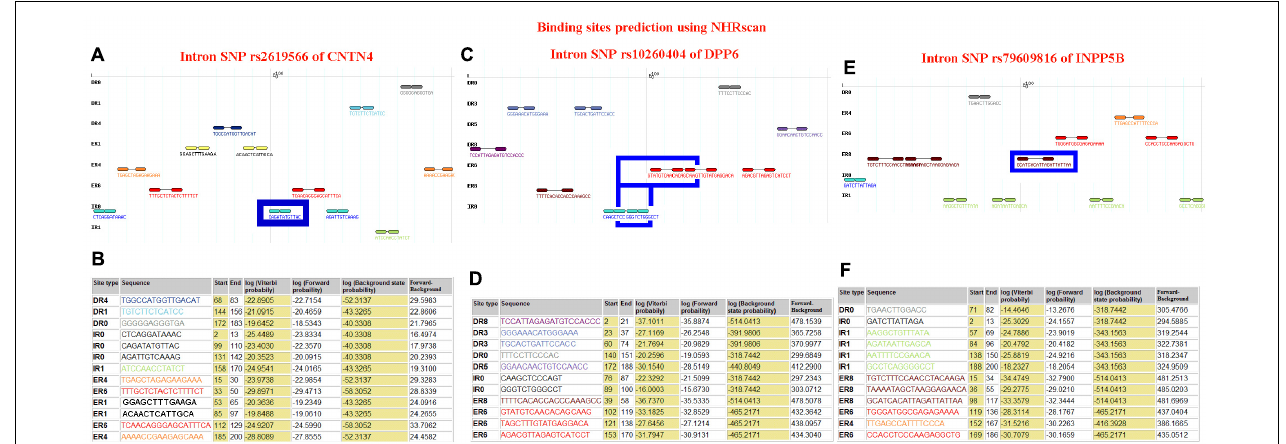
FIGURE 4 | Binding site prediction using NHRscan. (A) The IR0 CAGATATGTTAC sequence at positions 99–110 of the CNTN4 gene is predicted as a binding element, and the SNP is located at the third nucleotide position of the binding fragment. The sites marked using a blue frame indicate the predicted binding fragments. (B) Statistical information about the predicted binding sites of the CNTN4 gene. (C) The IR0 GGGTCTGGGCCT sequence at positions 89–100 and the ER6 GTATGTCAACACAGCAAG sequence at positions 102–119 of the DPP6 gene are predicted as binding fragments, and the SNP is located in the middle of the two binding fragments in the DPP6 gene. The sites marked using a blue frame indicate the predicted binding fragments. (D) Statistical information about the predicted binding sites in the DPP6 gene. (E) The ER8 GCATCACATTAGATTATTAA sequence at positions 98–117 of the INPP5B gene is predicted as a binding fragment, and the SNP is located at the fourth nucleotide position of the binding fragment. The sites marked using a blue frame indicate the predicted binding fragments. (F) Statistical information about the predicted binding sites in the INPP5B